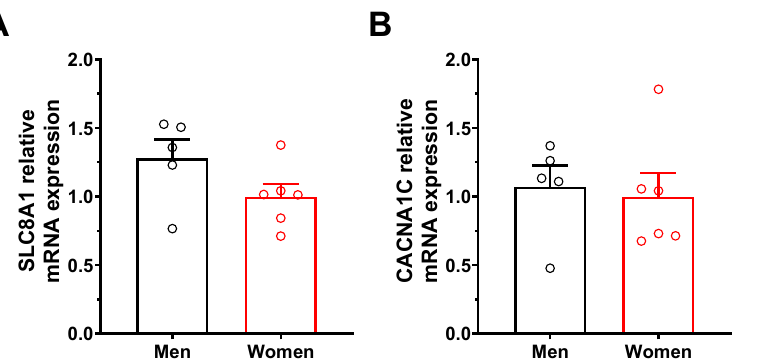
Figure 6. SLC8A1 and CACNA1C gene expression in human atria. Relative mRNA expression of ( A ) SLC8A1 (coding for NCX1) and ( B ) CACNA1C (coding for Ca V 1.2) in human atrial tissues from men and women without heart disease. The expression of genes of interest was normalized to the housekeeping gene HPRT1 ( SLC8A1 : M: 1.28 ± 0.14, n = 5; F: 1.00 ± 0.09, n = 6; p = 0.12; CACNA1C : M: 1.07 ± 0.16, n = 5; F: 1.00 ± 0.17, n = 6; p = 0.77).